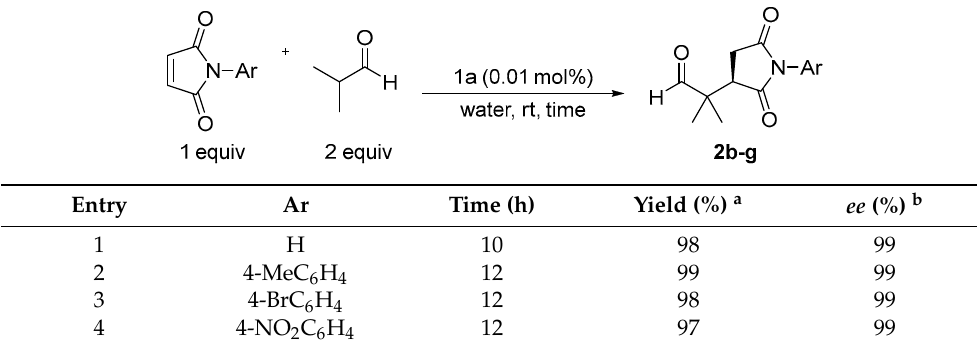
Table 2. Effect of various types of maleimide on the reaction.